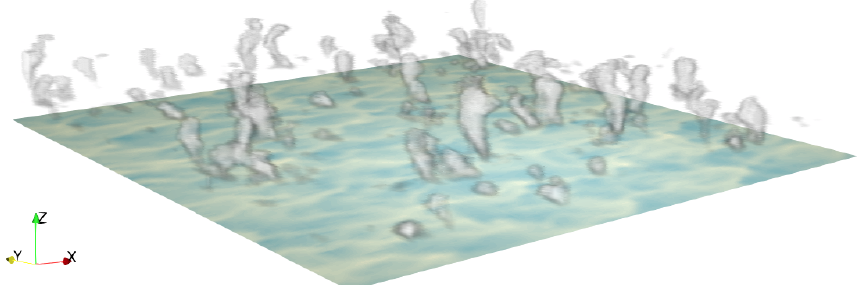
Figure 13. BOMEX. Instantaneous visualization of the shallow cumulus structures on a 30km × 30km × 3 . 6km domain. The white shading of the volume rendering of the cloud corresponds to a maximum value of q l = 2 . 5 × 10 − 4 kgkg − 1 ; a maximum q t = 1 . 8 × 10 − 2 kgkg − 1 is shown on the bottom surface in light yellow shading. The simulation was executed using 16 GPUs on the Google Cloud Platform.